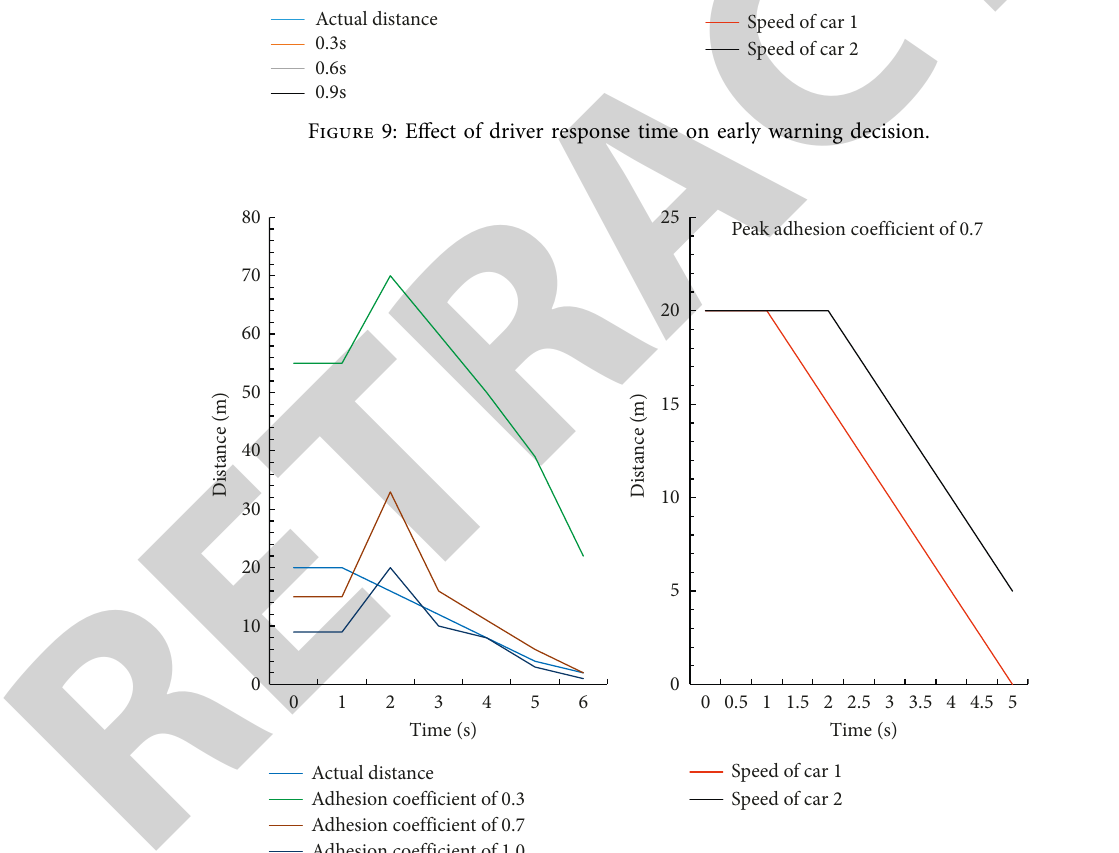
Figure 10: Impact of pavement conditions on early warning